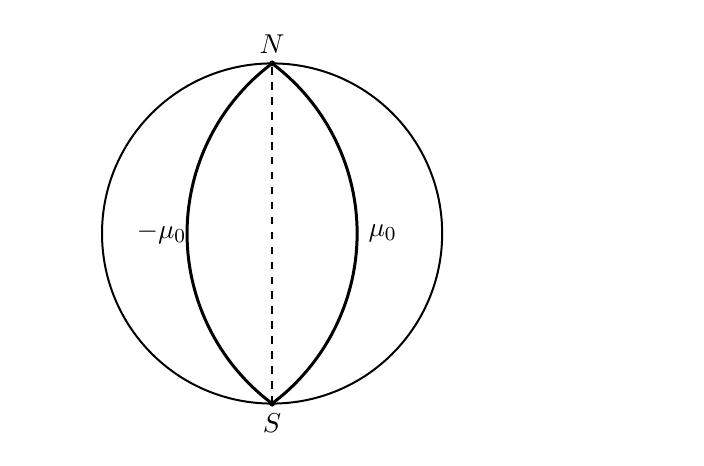
Figure 2 . Conformal diagram taken from [48] for the Janus AdS 3 geometry with Poincaré coor- dinates on the AdS slices. The polar angle corresponds to the coordinate µ ∈ [ − µ 2 radial coordinate is z ∈ [0 , ∞ ] . The joint W corresponds to the place where the two parts with the topology of half R 2 meet. It can be seen as a domain wall on the boundary.